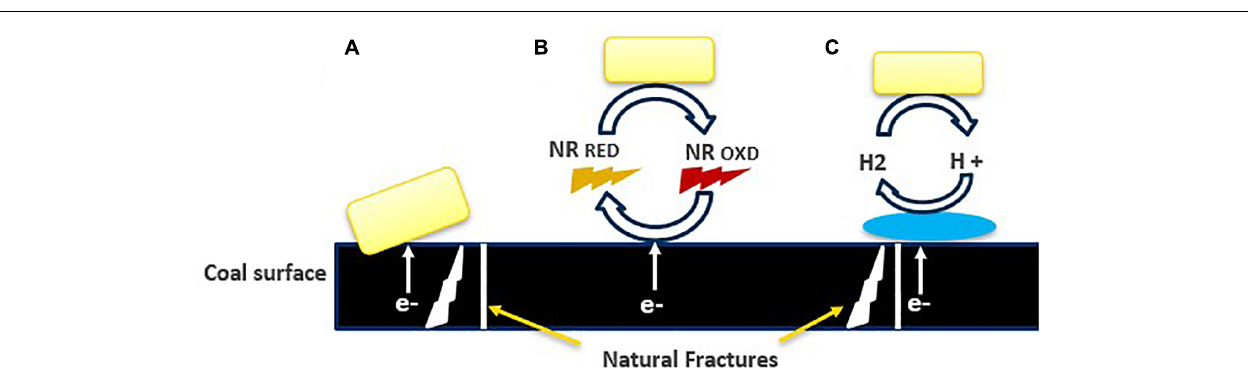
FIGURE 8 | Overview of proposed extracellular electron transfer mechanism (Lovley, 2011): (A) direct, (B) electron transfer mediated by dissolved redox mediators, and neutral red (proposed hypothesis), indicating that chemical processes occurring at nanoscale, (C) dependent on the H 2 generation catalyzed by extracellular